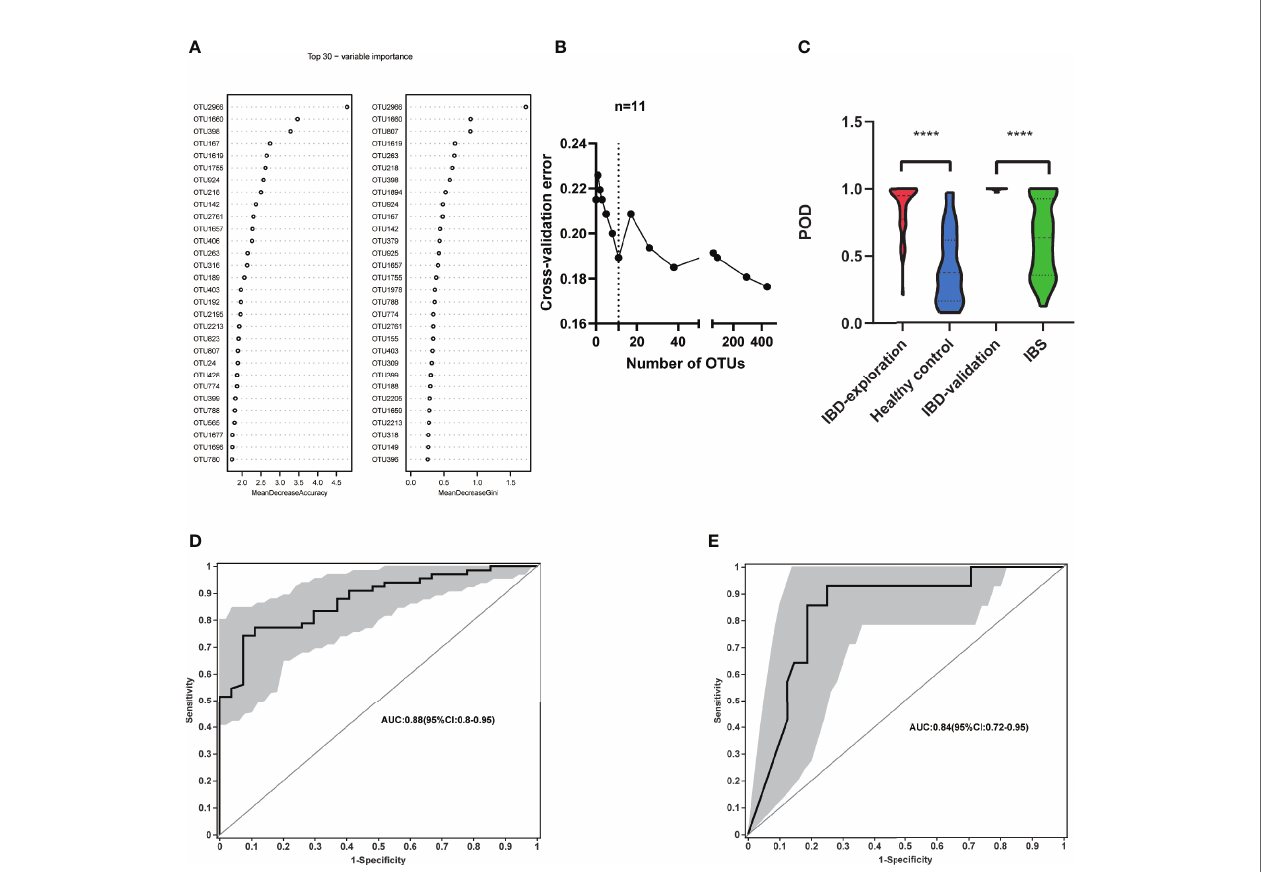
FIGURE 4 | Identi fi cation of microbial based markers of IBD by random forest models. (A) showed the top 30 main important IBD-associated OTU from random forest models. (B) The top 11 OTUs markers were selected as the optimal marker set by random forest models. (C) The POD value was signi fi cantly increased in the IBD samples versus the healthy control and IBS. Receiving operational curve analysis was performed in (D) exploration data (IBD: 66; control: 27, area under curve (AUC)=0.88) and in (E) validation data (IBD:14; IBS:48, AUC=0.84), respectively. Diagonal lines represent random classi fi cation (AUC=0.5). ****P<0.0001, AUC, area under the curve; IBD, in fl ammatory bowel disease; IBS, irritable bowel syndrome; OTUs, operational taxonomy units; POD, probability of